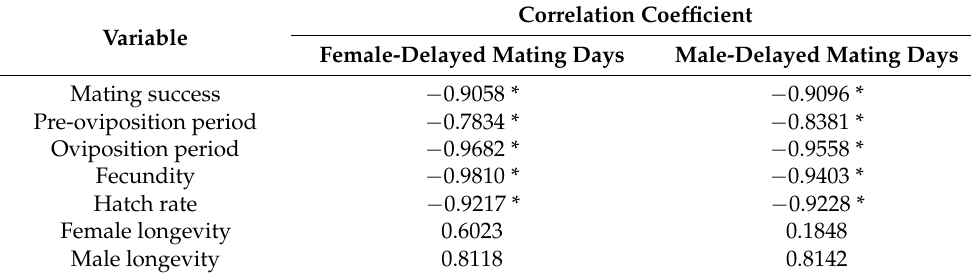
Table 2. Some reproductive variables of H. vigintioctopunctata in relation to the number of female-and male-delayed mating days.